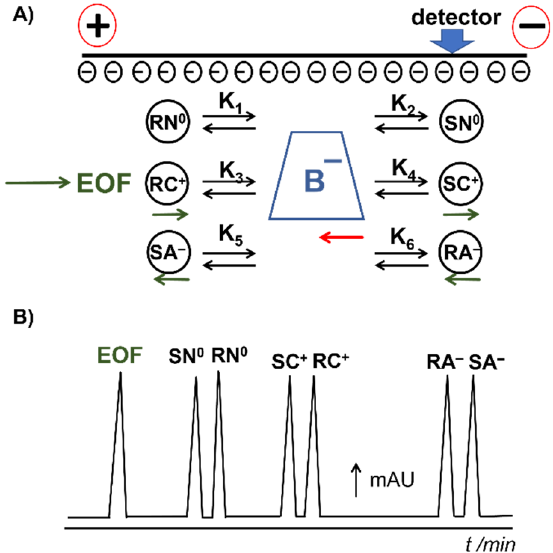
Figure 3. ( A ) Schematic on the chiral MEKC separation using bile salts of three hypothetical chiral species, neutral N 0 , cationic C + and anionic A - , in their R and S enantiomers. ( B ) Resulting electrochromatogram of the chiral MEKC separation of the three pairs of analytes.